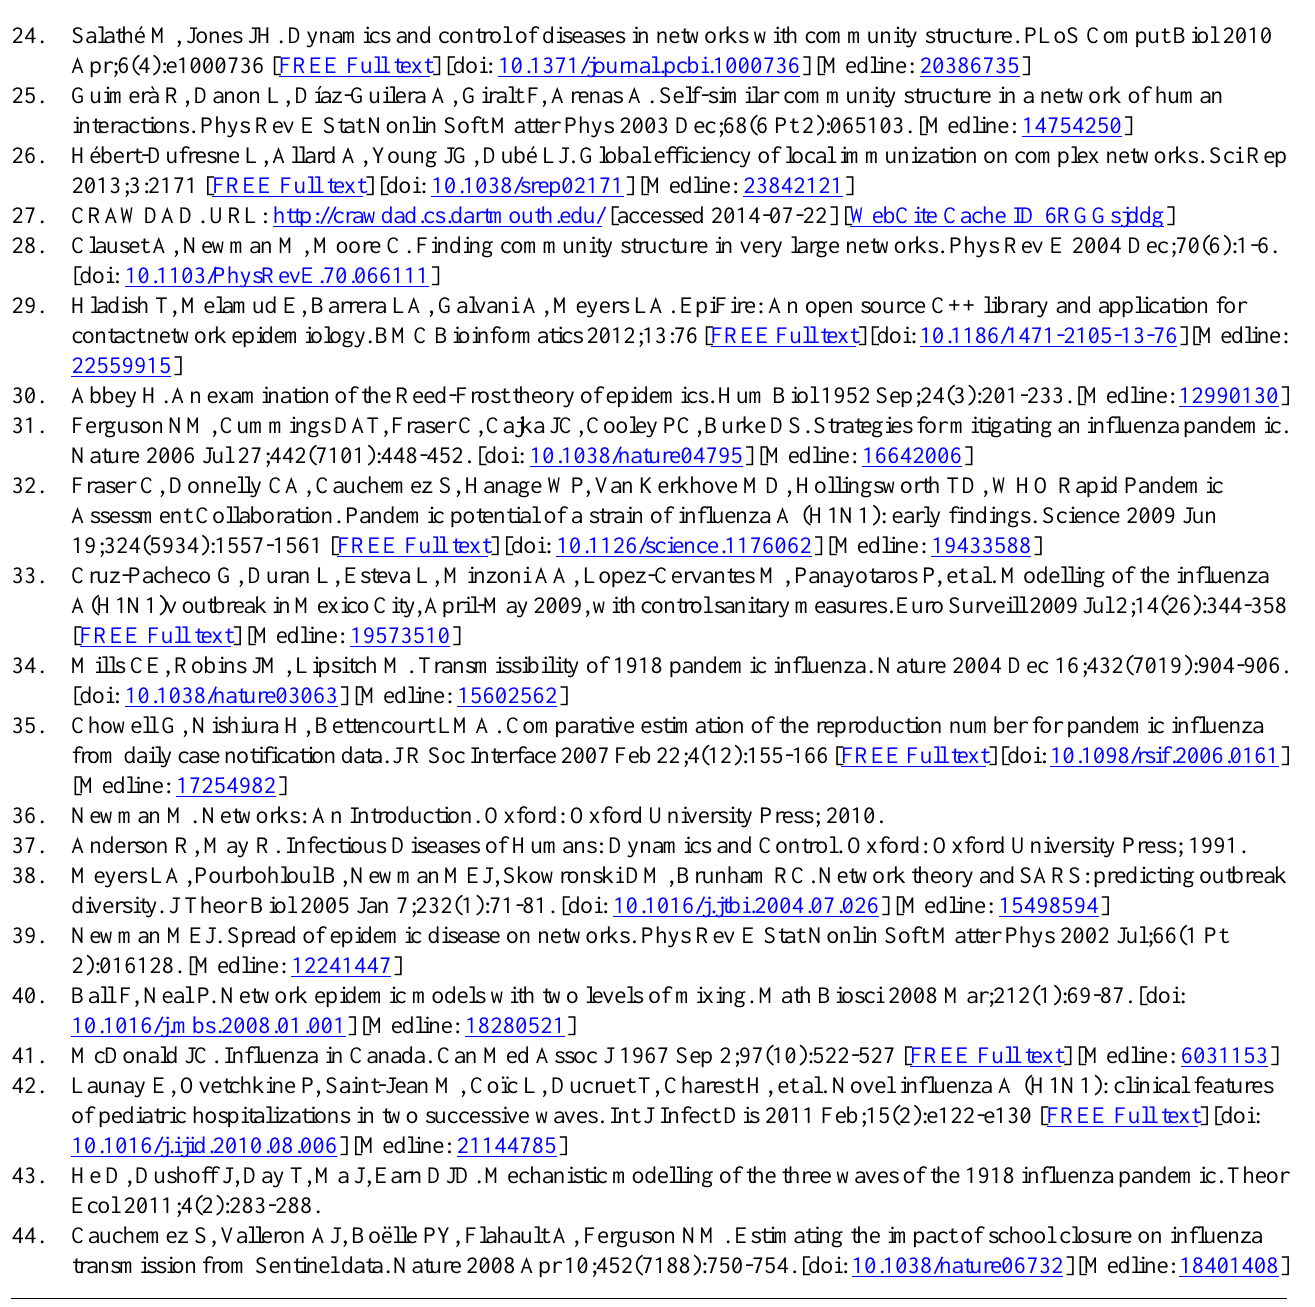
Abbreviations CRAWDAD: Community Resource for Archiving Wireless Data at Dartmouth ÎSF: Île Sans Fil R : basic reproductive 0